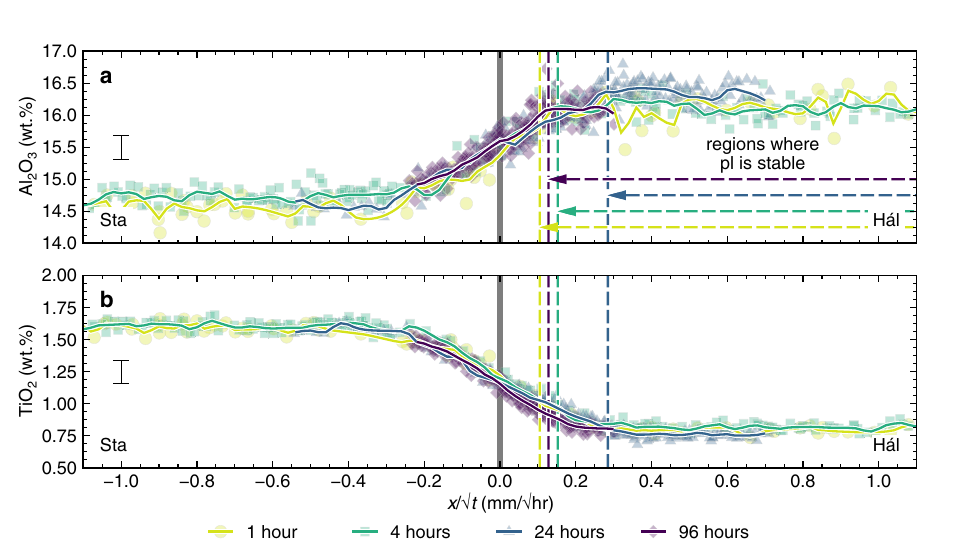
Fig. 6 Time-normalised glass composition pro fi les through the products of magma – magma reaction experiments. Normalising glass composition pro fi les by the square root of experimental duration eliminates the effects of time on the evolution of diffusively controlled pro fi les, which thus collapse onto single curves for each element 34,48 . Symbols are the same as in Fig. 5. Hál and Sta refer to Háleyjabunga and Stapafell lava analogues, respectively. a , b Closely overlapping time-normalised glass compositions pro fi les for Al 2 O 3 ( a ) and TiO 2 ( b ) con fi rm that chemical variability in the products of magma – magma reaction experiments was dominantly controlled by diffusion within experimental melts. Equivalent pro fi les are shown for all elements in Supplementary Fig.